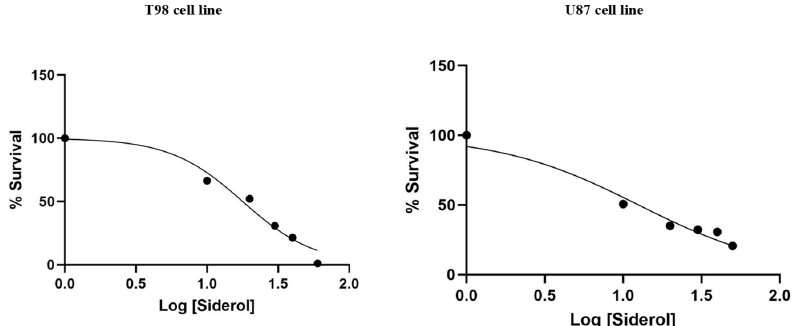
Figure 2. Cytotoxic effect of Siderol on T98 and U87 cell lines, 72 h after treatment. Values are the means of three independent experiments and are normalized to non-treated cells. The IC50 values were determined using the non-linear regression analysis model of GraphPad Prism Version 6.